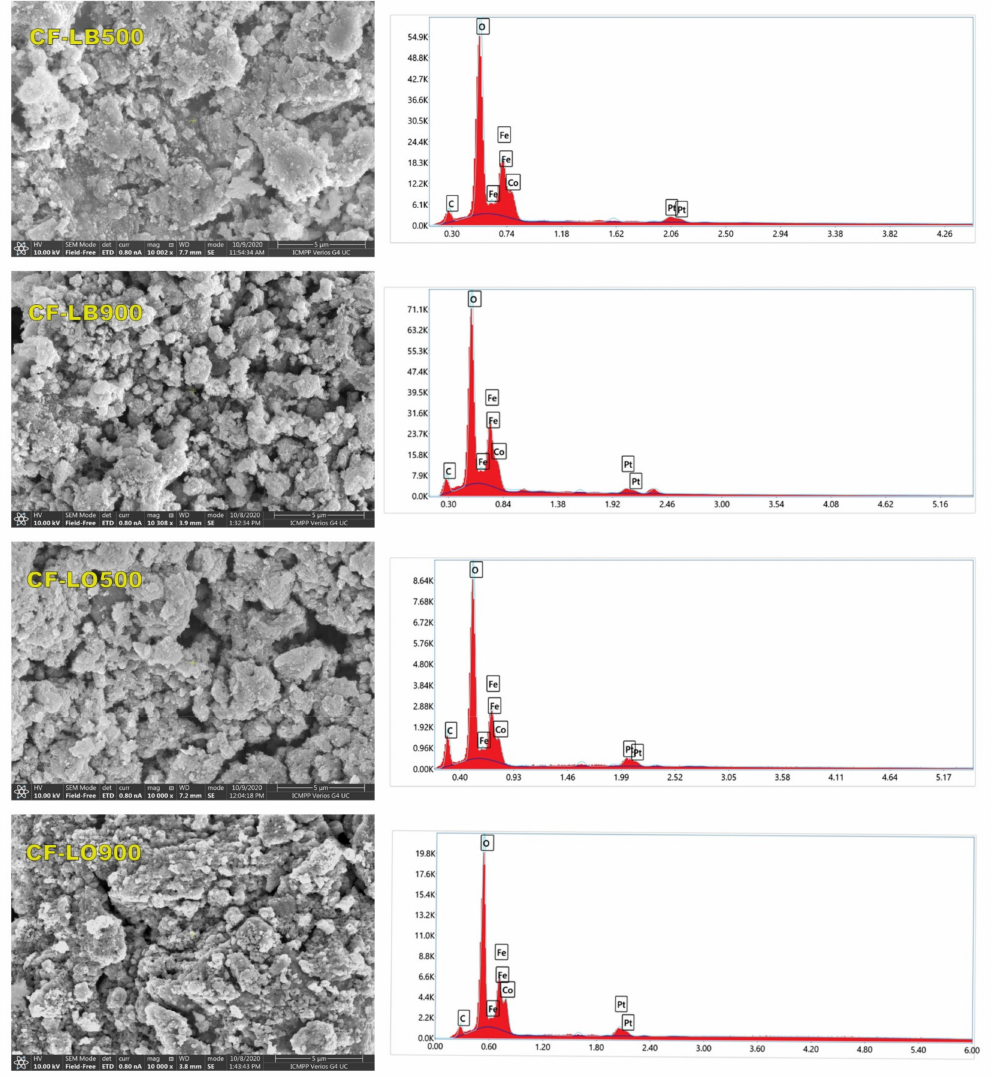
Figure 4. SEM micrographs ( × 10,000 magnification) and EDX spectra of hybrids